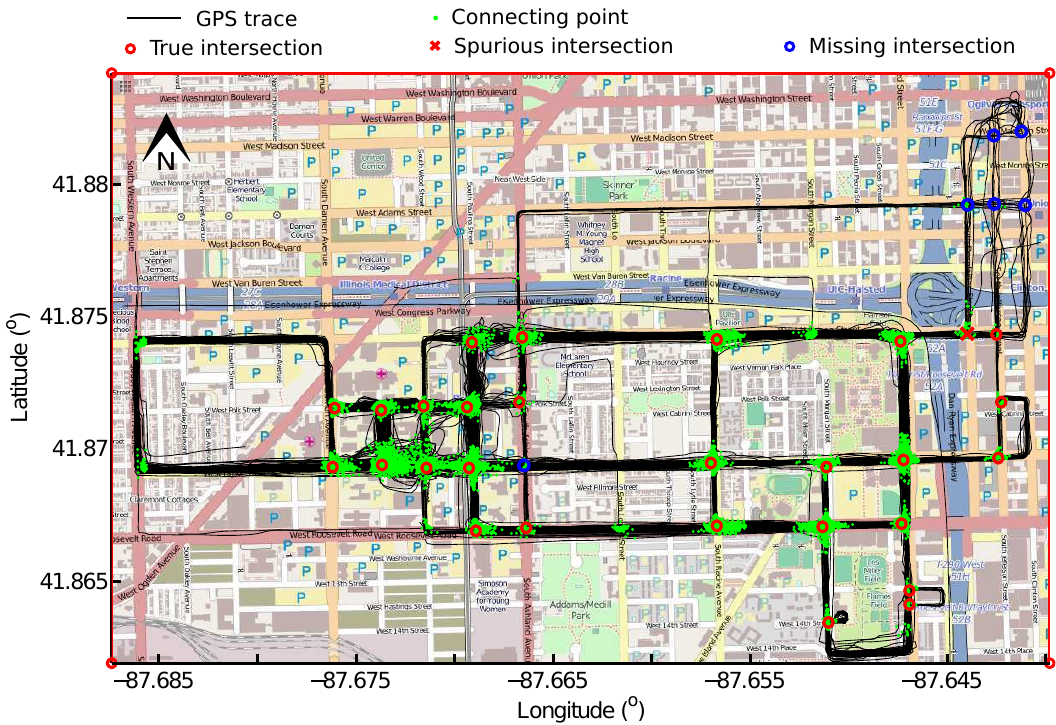
Figure 12. Intersections detected our previous LCSS method.